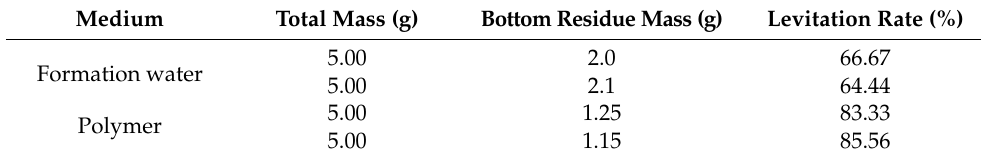
Table 5. Particle Suspension Test Results in Formation Water and Polymer